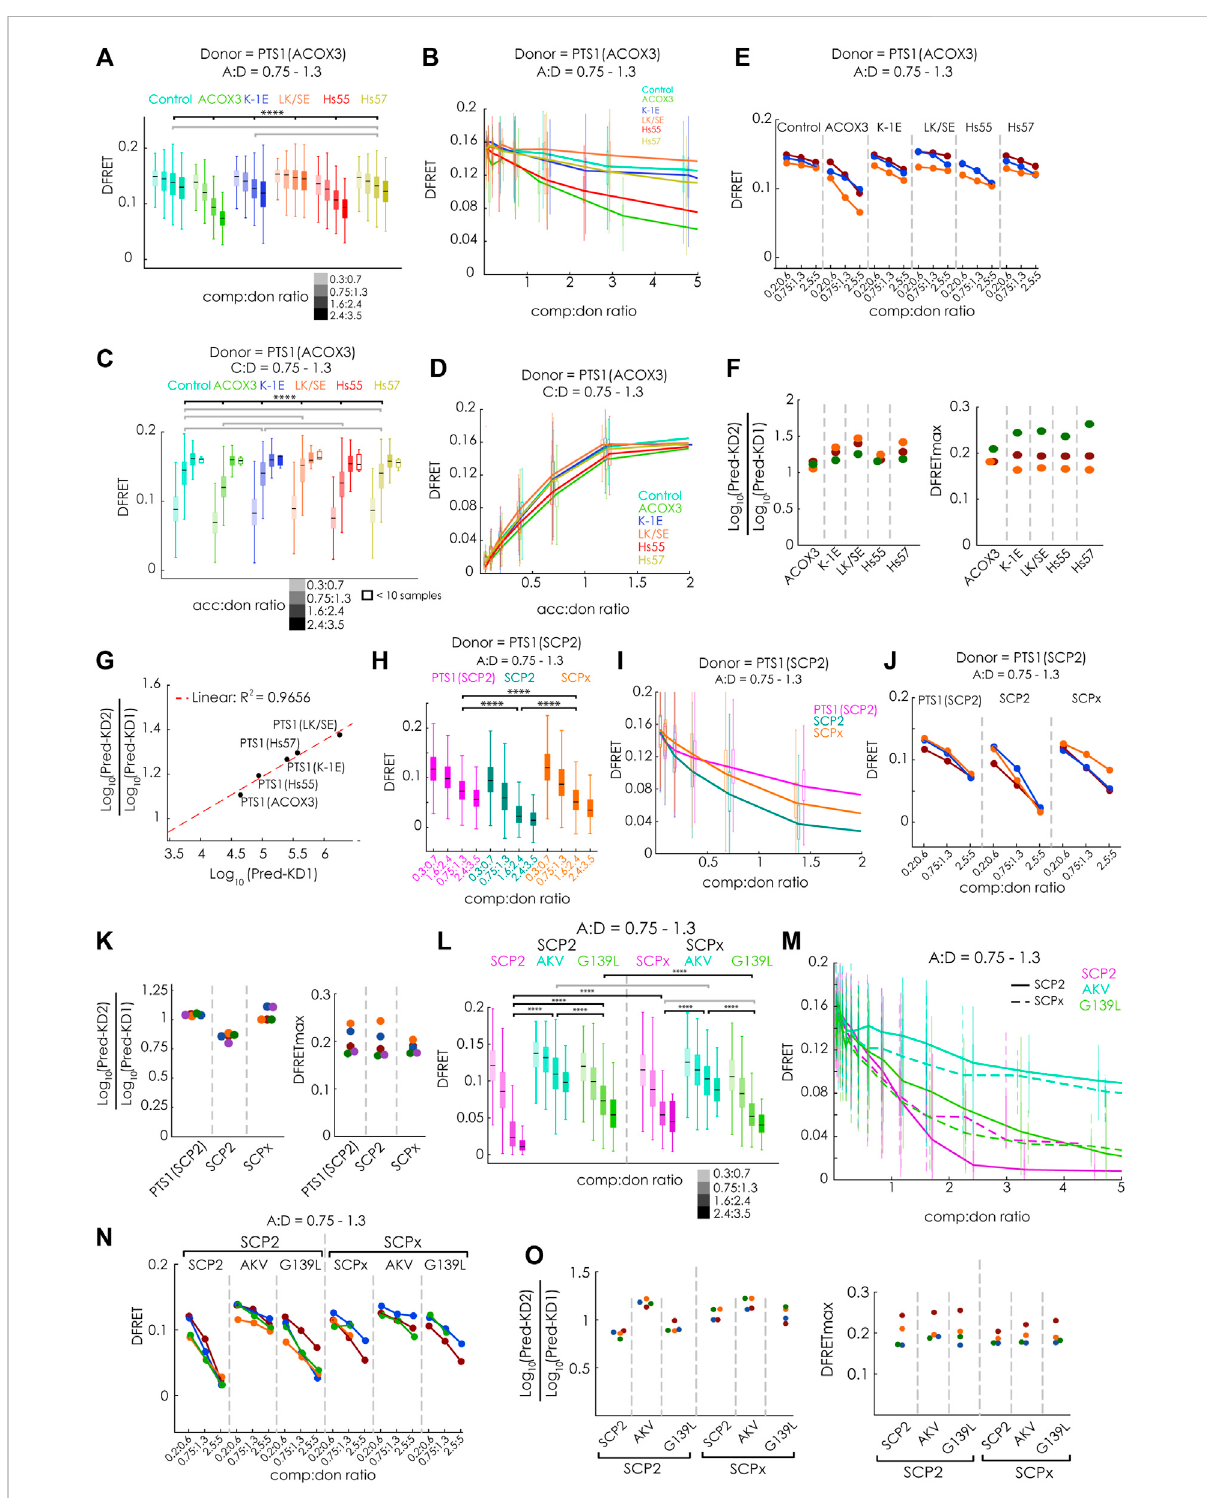
FIGURE 4 FlowFRET competition assays in living cells allow the discrimination of af fi nities and is applicable to large proteins: pex5 − / − MEF expressing mCherry-PEX5(TPR) as acceptor and various donor and competitor molecules were analyzed by fl ow cytometry to obtain a large number of cells: (A – G) donor: EGFP-PTS1 (ACOX3), competitor: various Cerulean-PTS1 proteins harboring the PTS1 motifs of Hs55, Hs57, ACOX3, ACOX3_K-1E, ACOX3_LK/SEorCeruleanalone; (H – K) donorEGFP-PTS1(SCP2),competitorCerulean-PTS1(SCP2),Cerulean-SCP2orCerulean-SCPx; (L –